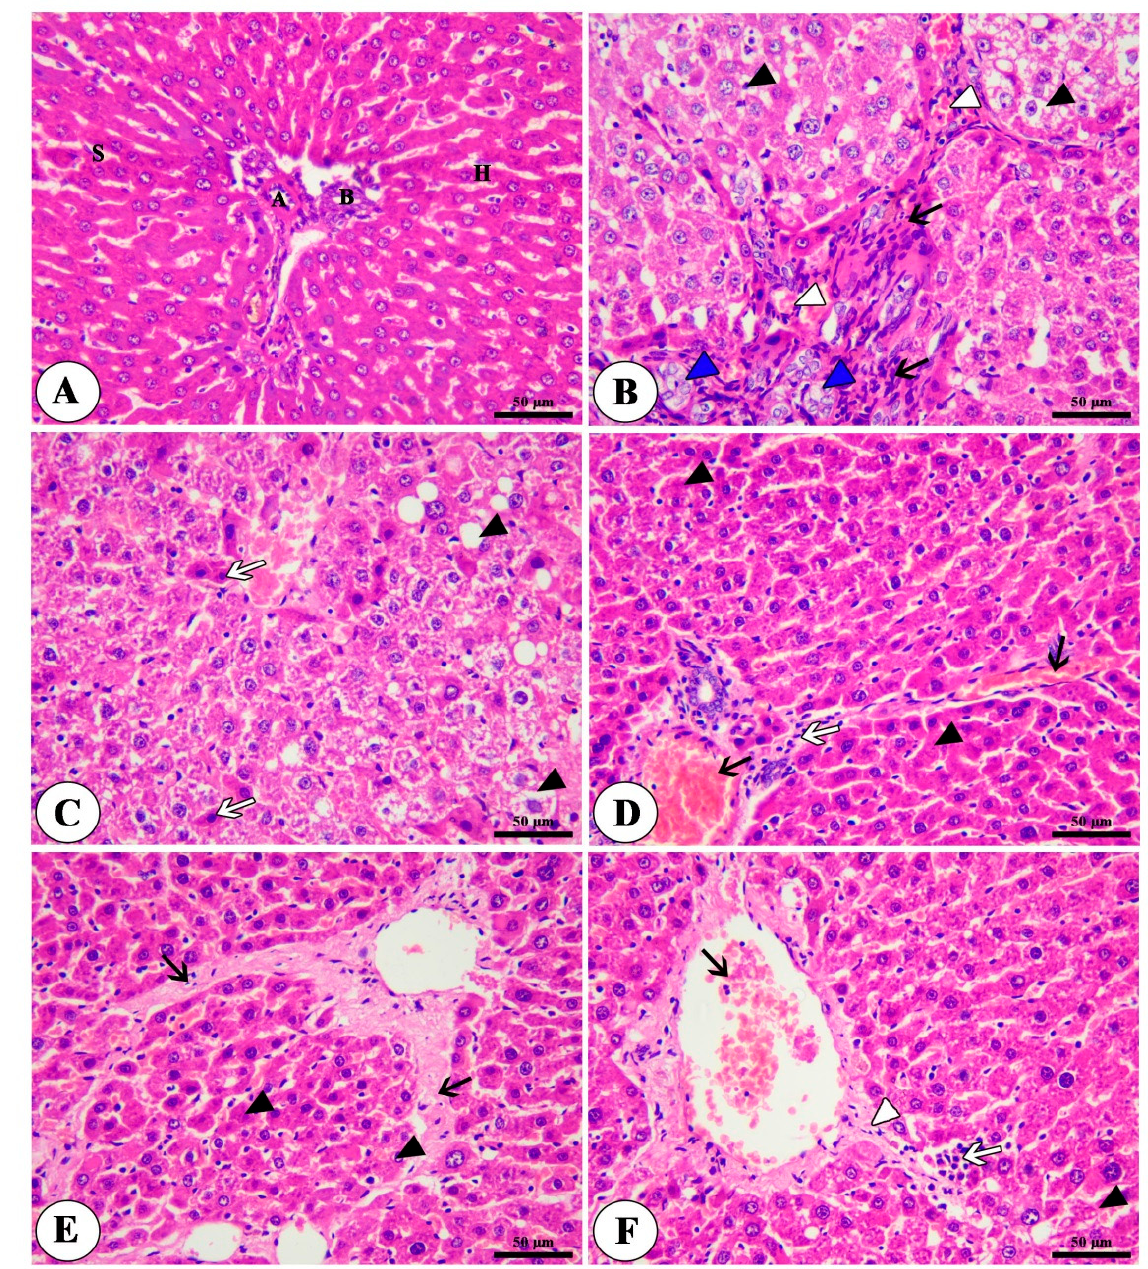
Figure 4. Photomicrograph of Liver tissue of different treated groups; control group ( A ) showing normal architecture of liver, hepatic artery ( A ), bile duct ( B ), polyhedral-shaped hepatocytes (H) arranged in a cord-like pattern and separated by blood sinusoids (S). HCC group ( B , C ) showing loss of hepatic architecture, cytologic atypia (blue arrow heads), swelling and macrosteatosis of some hepatocytes (black arrowhead), the presence of cells with strong acidophilic cytoplasm and hyperchromatic nuclei (white arrows), new blood vessel formation (white arrow heads) and fibrosis (black arrows). NSP-treated group ( D ) showing a moderate atypia of hepatocytes (black arrow heads), congestion of hepatic blood vessels (black arrows) and mild mononuclear cell infiltration (white arrows). Sorafenib-treated group ( E ) showing moderate atypia and degenerative changes of hepatocytes (black arrow heads), fibrosis (black arrows). NSP + sorafenib-treated group ( F ) showing normal hepatic architecture with mild hepatocellular degeneration (black arrow head), mild fibrosis (white arrow head), mild congestion of the central vein (black arrow) and mild mononuclear cell infiltration (white arrows). H&E, Bar = 50 µm.